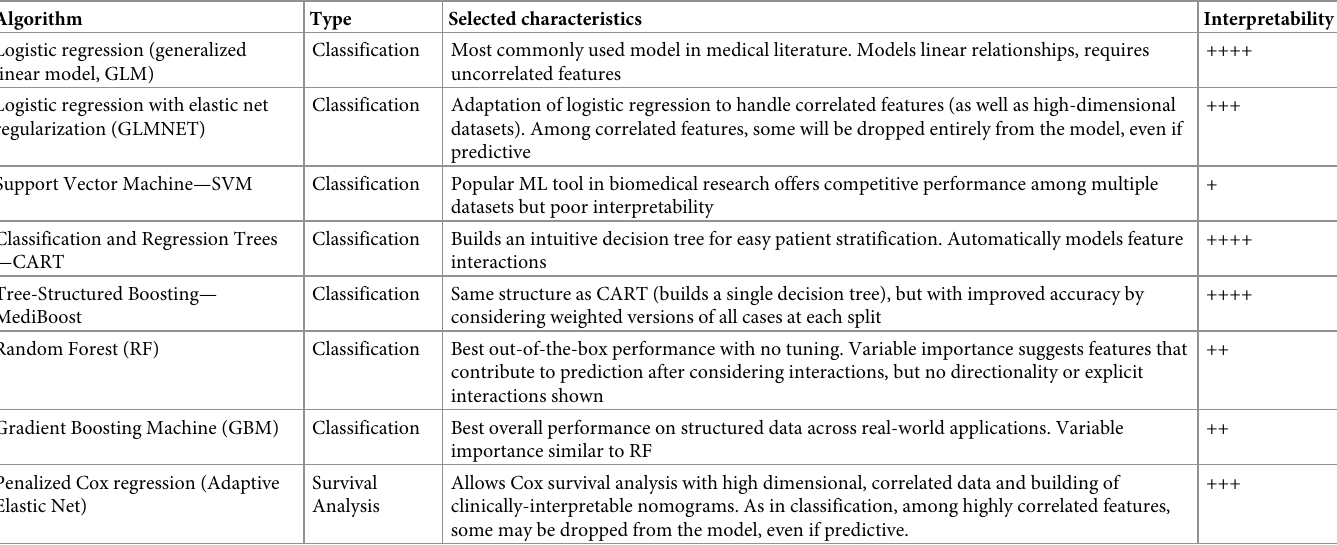
Table 1. Algorithms.